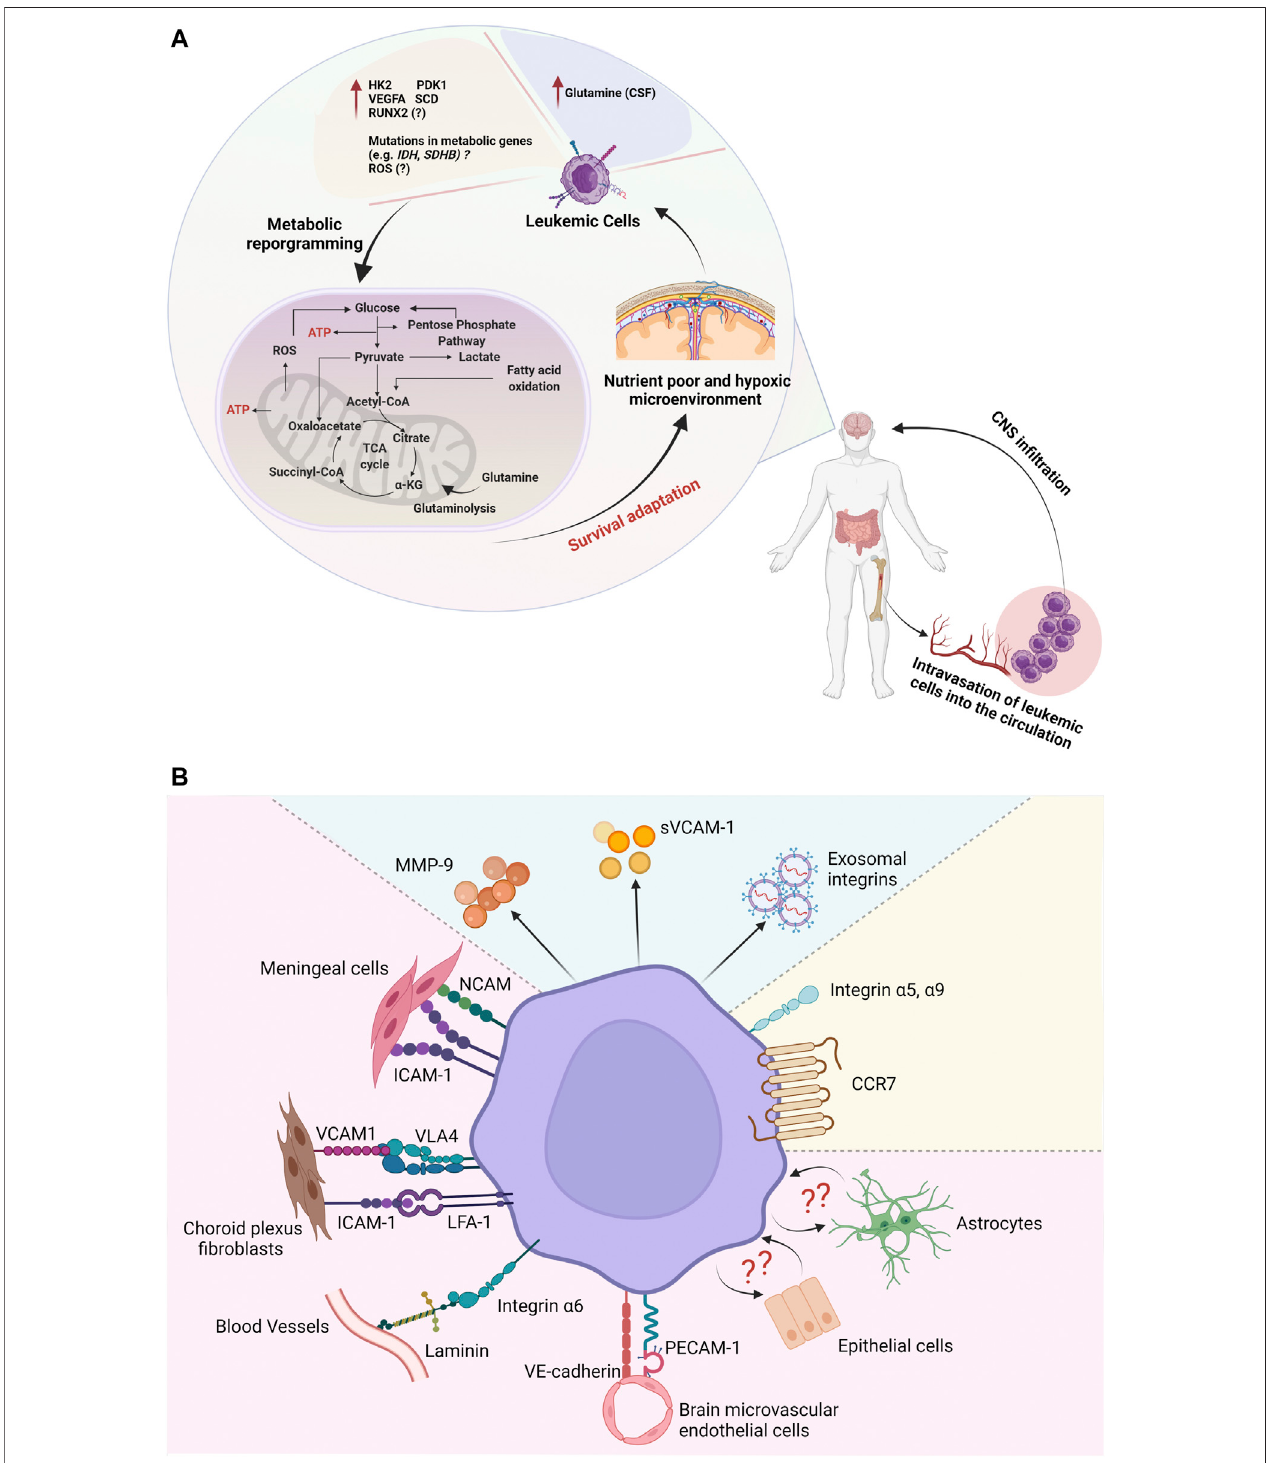
FIGURE1| Aschematic illustration ofmetabolic reprogrammingand adhesion pathways involvedinthe central nervous system(CNS) niche inacute leukemia. (A) Leukemic cells can adapt to nutrient-poor and oxygen-deprived CNS by modulating the expression of metabolic and hypoxia-associated genes. (B) Upregulation of adhesion molecules may facilitate leukemic cell in fi ltration and survival in the CNS microenvironment.